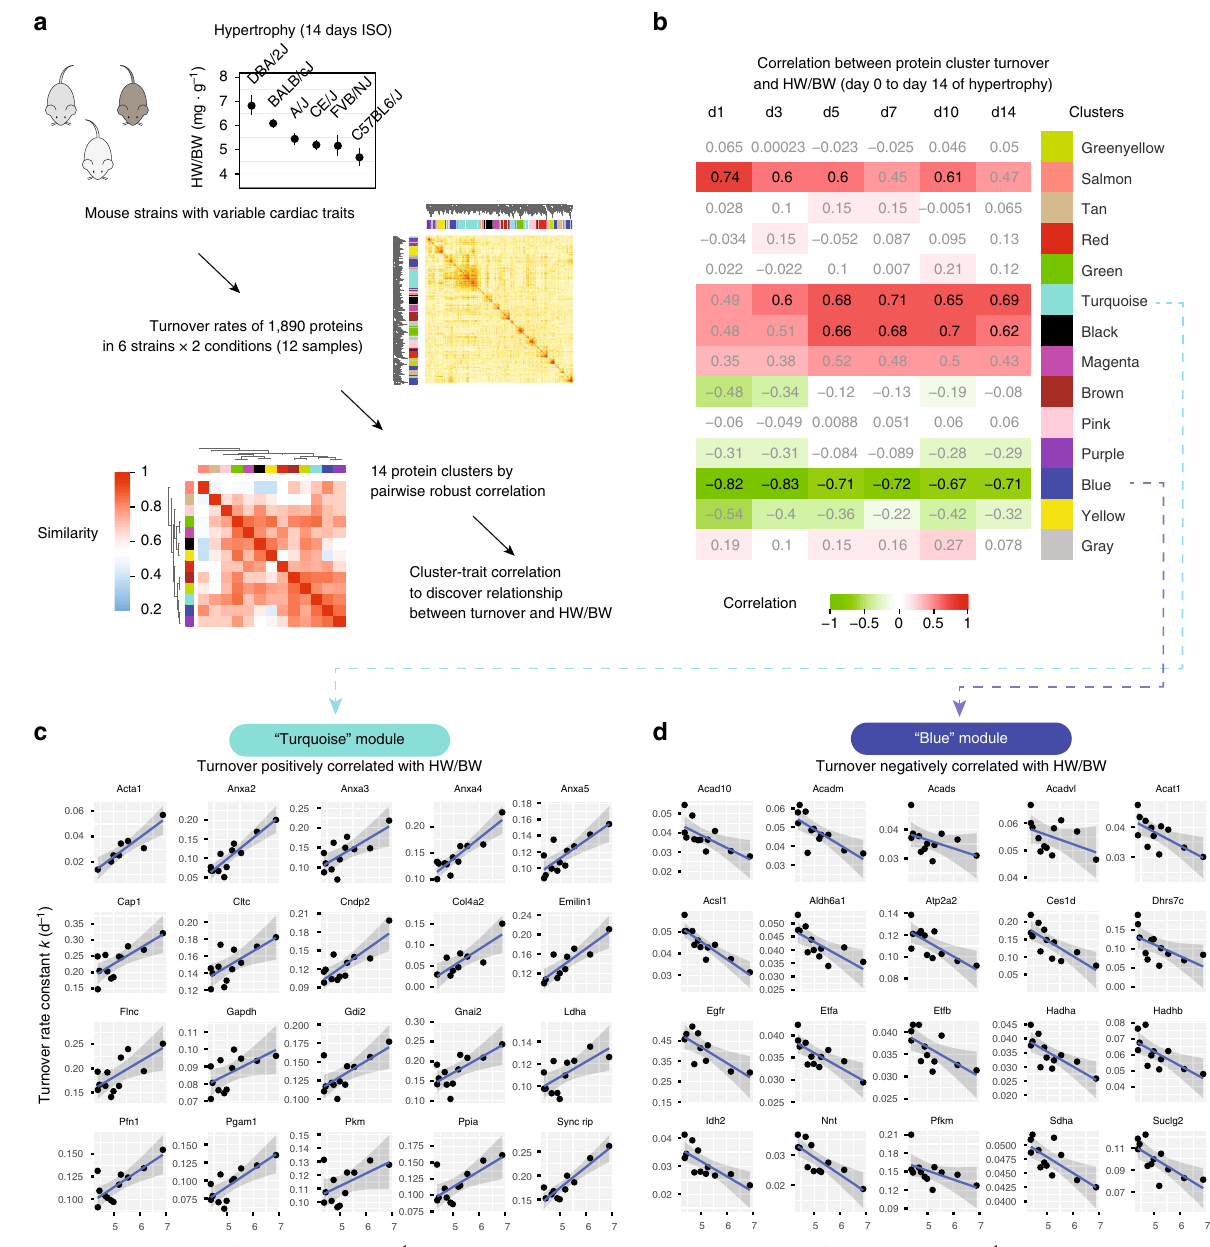
Fig. 5 Coordinated temporal dynamics of protein clusters in cardiac hypertrophy. a The six mouse strains show differential heart-weight-to-body-weight ratios (HW/BW; y -axis; error bars: s.d.) over 14 days of beta-adrenergic stimulation ( x -axis). Turnover rates of 1890 proteins in the six genetic strains in normal and hypertrophy are clustered based on their normalized turnover rates into 14 modules. b Correlation between cluster protein turnover and HW/BW among the six genetic strains during hypertrophy. Heat map colors and numbers denote correlation coef fi cient ρ . Black texts: suggestive correlation ( P < 0.05; Benjamini – Hochberg adjusted P > 0.05); Bold texts: signi fi cant correlation (adjusted P < 0.05). c Turnover of proteins in the module labeled “ Turquoise ” is positively correlated with hypertrophy. The module includes membrane remodeling proteins (ANXA2, ANXA5), extracellular proteins (e.g., COL4A2), and glycolytic proteins (e.g., LDHA, PGAM1) (20 representative proteins shown). The data points: log 2 turnover rates ( y -axis) vs. HW/BW (mg per g) ( x -axis). Blue line: local regression; area: con fi dence interval. d Turnover of proteins in the “ Blue ” module is negatively correlated with hypertrophy. The module is highly enriched in fatty acid oxidation proteins including ACAD10, ACAT1, ACSL1, ETFA, ETFB, and (hypergeometric test P < 2.2e-16). This observation is preserved after correcting for protein abundance and protein localization (Fig. 6e). Moreover, the synchronizing relationship between protein – protein interaction and protein turnover became stron- ger during hypertrophy ( P : 1.4e-9) (median 1.58-fold differences in real pair vs. 1.90-fold in permuted pairs) (Fig. 6f). To further